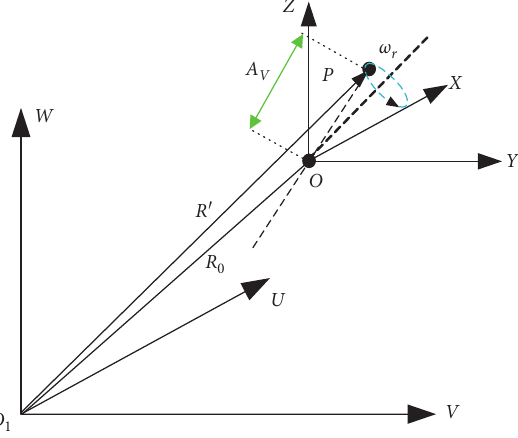
Figure 1: The micromotion model for the decoy